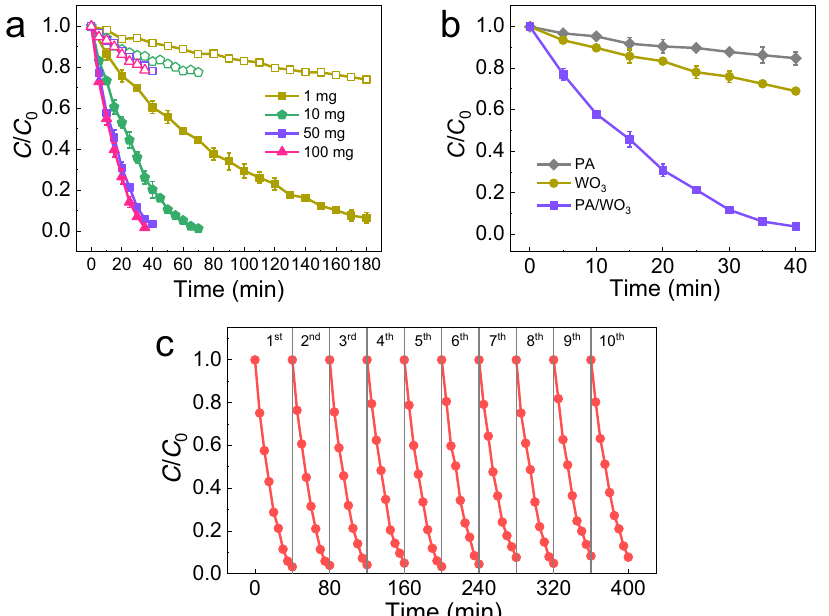
Fig. 2 Visible light-driven PCD of formaldehyde (FA) at 500 ppbv on PA/WO 3 . a The dark control tests (open symbols) and the PCD tests ( fi lled symbols) over PA/WO 3 (1:1) with different catalyst mass (e.g., 10 mg catalyst composed of 5 mg PA and 5 mg WO 3 ). b PCD of FA on PA/WO 3 , bare WO 3 and PA. Error bars are de fi ned as standard deviation. c Repeated PCD cycles of FA degradation over 50 mg PA/WO 3 . Experimental conditions: [FA] 0 = 500 ppbv; blue LED ( λ = 460 nm) intensity of 2.0 mW/cm 2 ; RH 65%; reaction temperature of 30 °C.